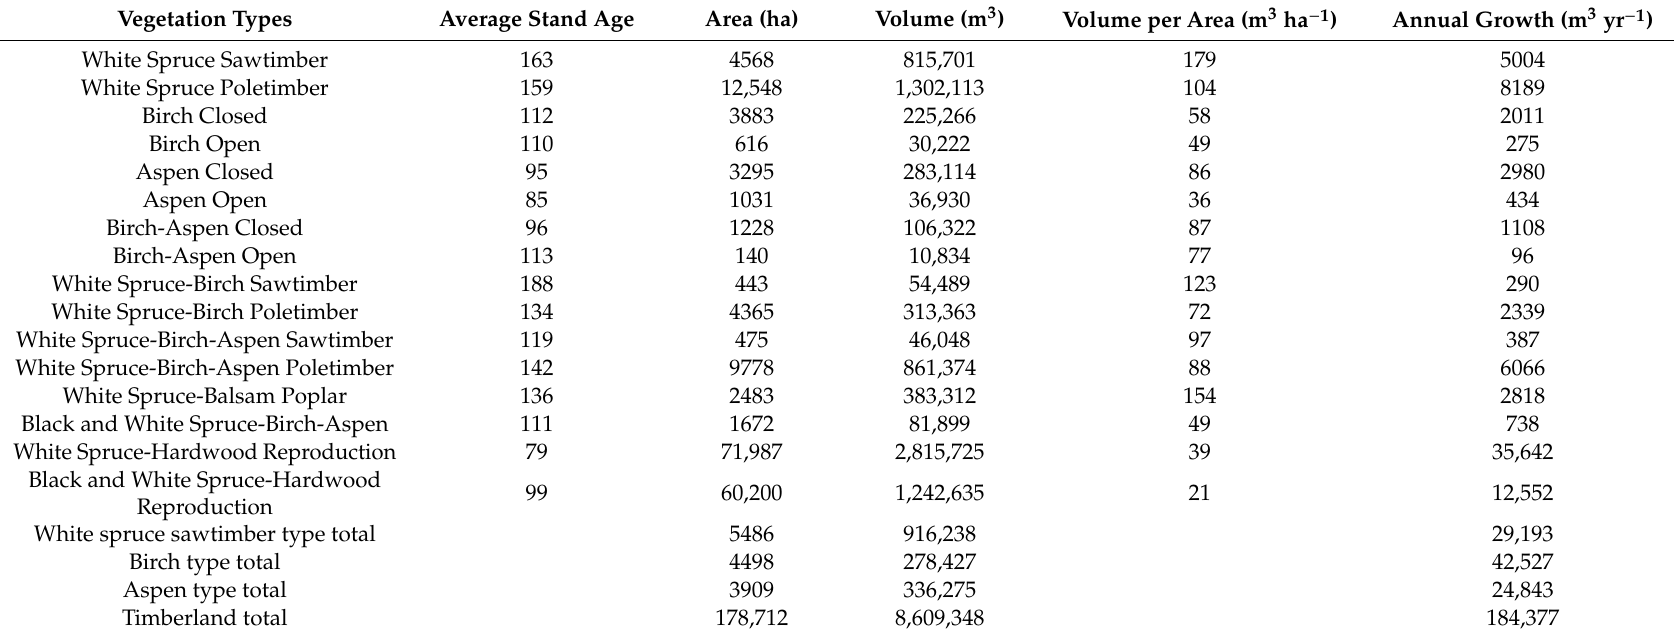
Table 5. Average stand age, area, timber volume, volume per area, average annual growth, and annual growth of each timberland vegetation type on state forest lands (Tok management